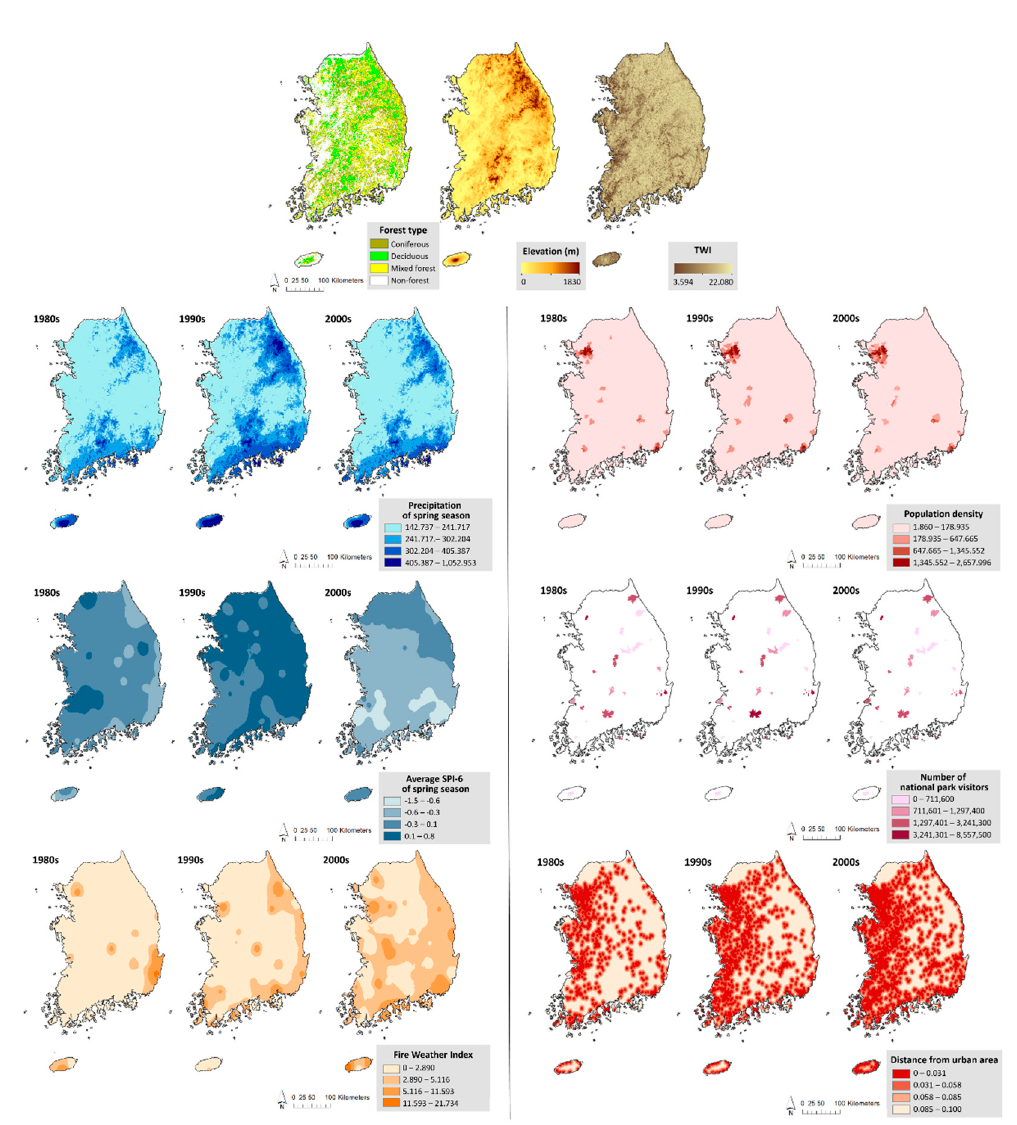
Figure 5. Maps of environmental and socio-economic input variables for the 1980s, 1990s, and 2000s. The socio-economic variables included the population density ( pop ), number of national park visitors ( visitors ), and distance from urban area ( urban ). The primary data of socio-economic variables, predominantly statistical data, were transformed into spatial data using ArcMap 10.4.1. The population data was given as statistical but non-spatial data, and the administrative boundaries were given as polygon data at the municipal level. The population was spatially joined to the polygon data, and the population density was then calculated within the boundaries. The number of national park visitors was also given as statistical data and was spatially joined to the national park boundaries. The rest of the area in this study was interpolated using the IDW method. Distance from the given area to an urban area was calculated using the Euclidean distance. We used the land cover map derived from the Landsat 1, 2 MSS, 5 TM, and 7 ETM provided by BIZ-GIS to calculate the distance between a certain grid point and an urban area [57]. For this study, all the input variables were set to a spatial resolution of 1 km in an ASCII grid format for the Maxent, and into a point format for the